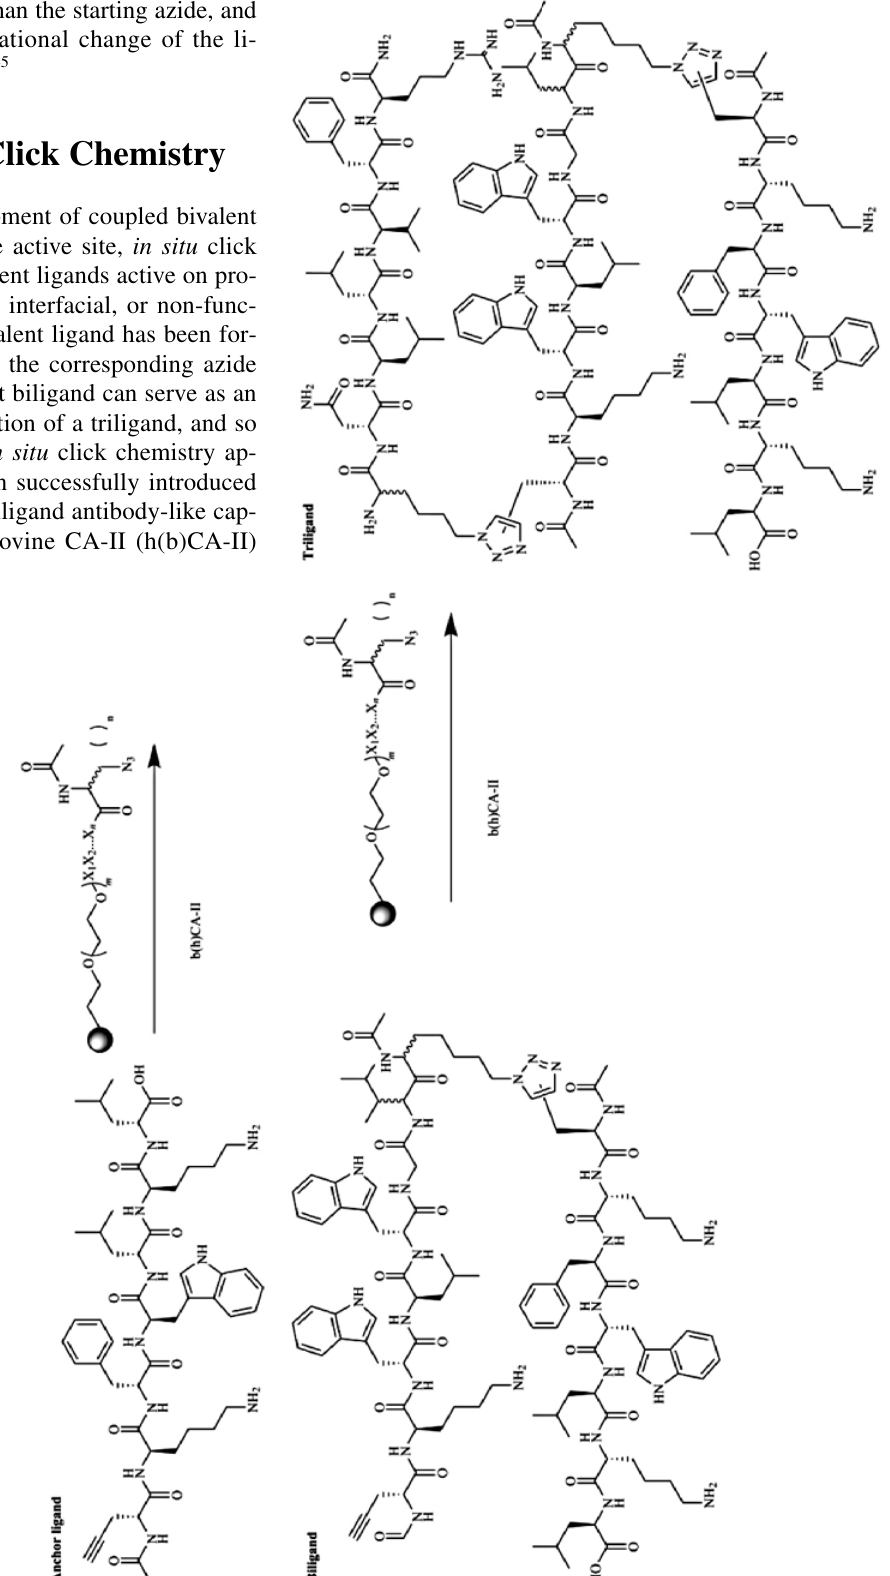
Figure 17. Iterative in situ click chemistry approach for developing triligand capture agent for human or bovine carbonic anhydrase II (b(h)CA-II).